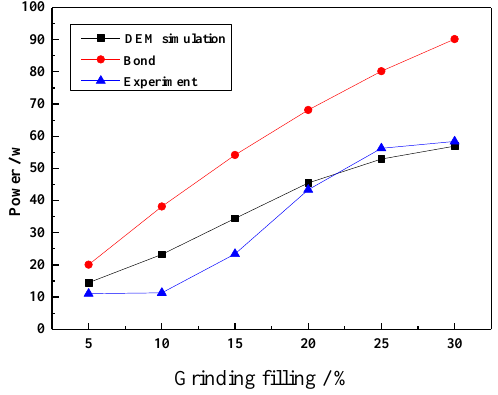
Figure 10. Power draw at different grinding media filling.